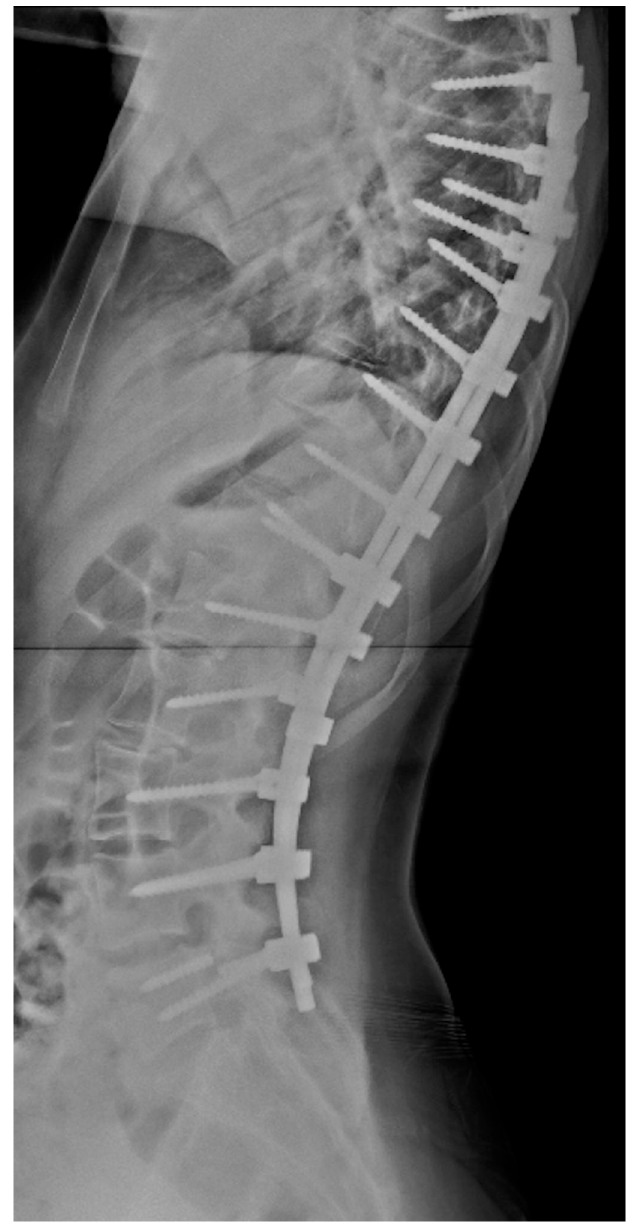
Figure 1. Lateral X-ray showing pedicle screw breakage at L5. The ability to ambulate is a protective factor against material failure (RR, 0.27), and patients with neuromuscular scoliosis, excluding cerebral palsy as an etiology, are 3.33 times more likely to have mechanical failure than patients with idiopathic scoliosis